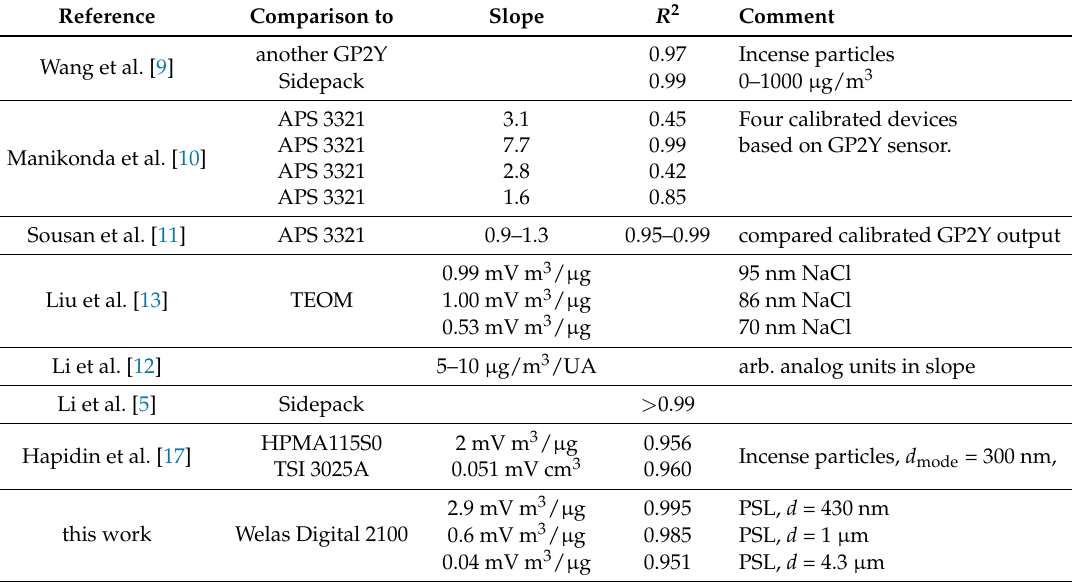
Table 3. Literature review of GP2Y comparison to other